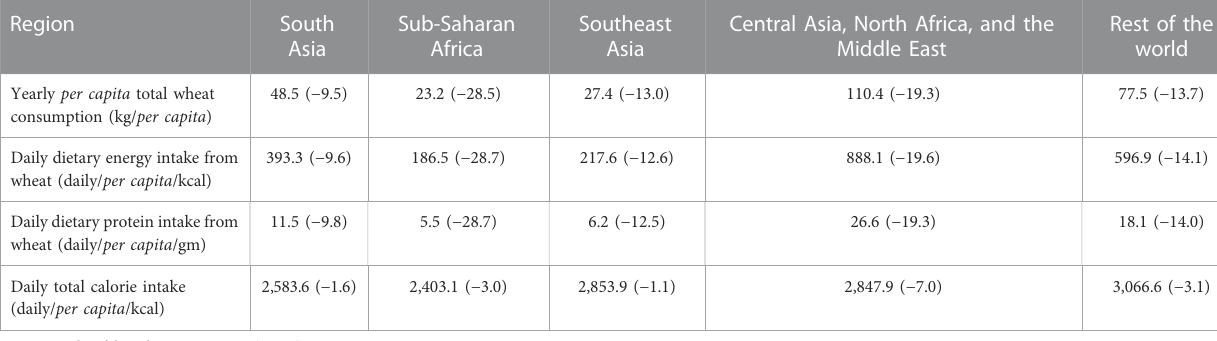
TABLE 8 Impacts of a 50% reduction in wheat exports from Russia and Ukraine on wheat consumption and nutrient intake in the sampled region.